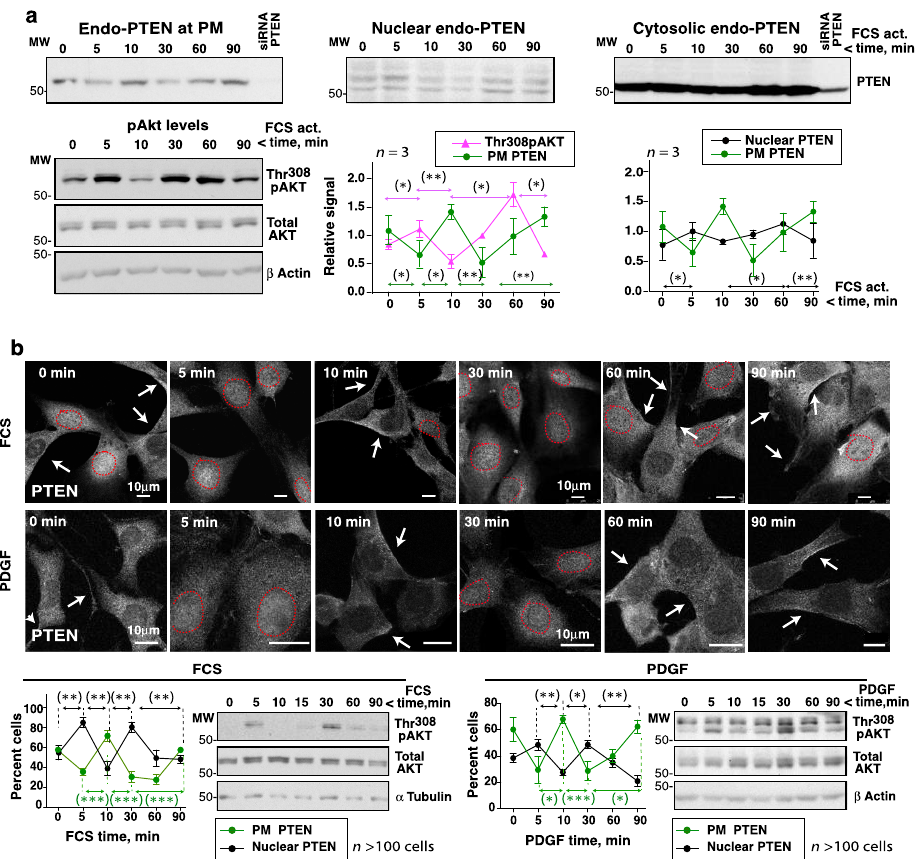
Figure 5. Cell activation with FCS or PDGF alters PTEN localization at the times of pAKT peaks and troughs. ( a ) HEK-293T cells were incubated in serum-free medium (2 h) and then stimulated with FCS (15%). The pAKT content in WCE was tested in a fraction of the cells (indicated). The remaining cells were subjected to fractionation to isolate the cytosol, PM, and nuclear fractions. Blots show the PTEN levels in the different fractions. The graphs show the pAKT and PTEN signals corrected for the AKT and the cell fraction marker contents, respectively, and normalized to the mean pAKT or PTEN signal (equivalent to 1) (mean ± SD, n = 3). ( b ) Representative IF images from an assay (of n = 4 with similar results) showing the PTEN signal in NIH3T3 cells incubated in serum-free medium (2 h) and then stimulated with FCS (15%) or PDGF (50 ng/mL) for different times. A fraction of the cells was lysed and the pAKT levels at different times examined by WB. The graphs show the percentage of cells with a PM PTEN-positive signal (arrows), or a PTEN-nuclear positive signal (surrounded by a dashed red line) (mean ± SD, n > 100). ( a , b ) * p < 0.05, ** p < 0.01, *** p < 0.001 Student’s t test.